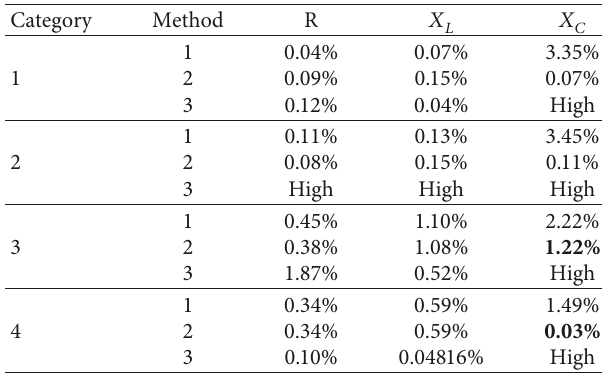
Figure 6: Calculation average errors of the six loading scenarios for the three methods under Category 1. (a) Resistance. (b) Reactive inductance. (c) Shunt admittance. Table 4: Maximum errors of the six loading scenarios considering the variation of the line